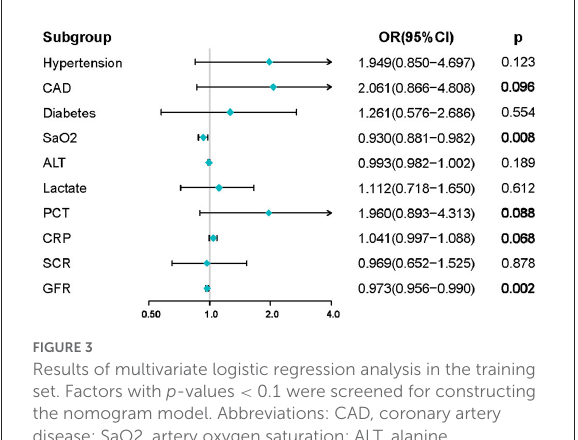
FIGURE3 Results of multivariate logistic regression analysis in the training set. Factors with p -values < 0.1 were screened for constructing the nomogram model. Abbreviations: CAD, coronary artery disease; SaO2, artery oxygen saturation; ALT, alanine aminotransferase; PCT, procalcitonin; CRP, C-reactive protein; GFR, SCR, serum creatinine; GFR, glomerular filtration rate.